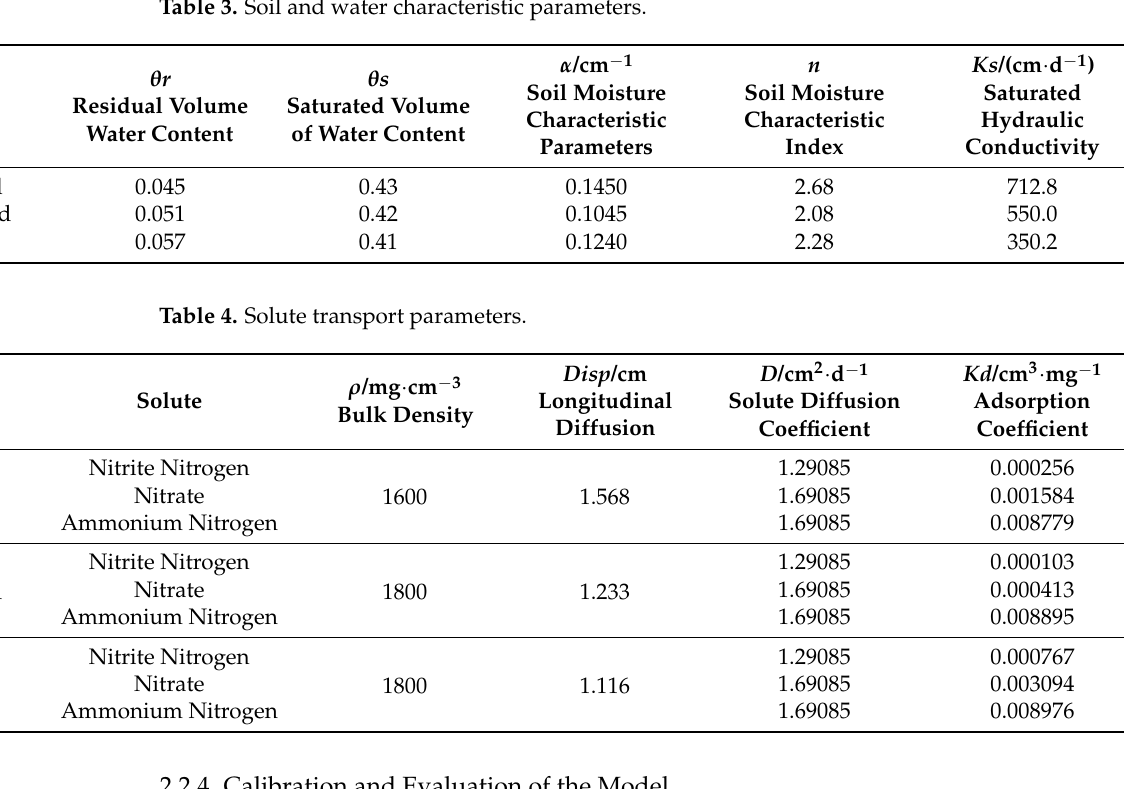
Table 3. Soil and water characteristic parameters.